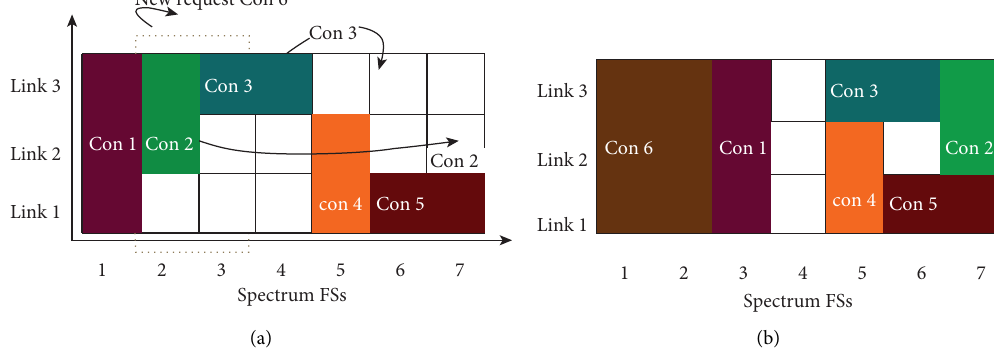
Figure 7: Te network reconfguration (a) before the reconfguration (b) con 6 accommodated after possibly reconfguring con2 and